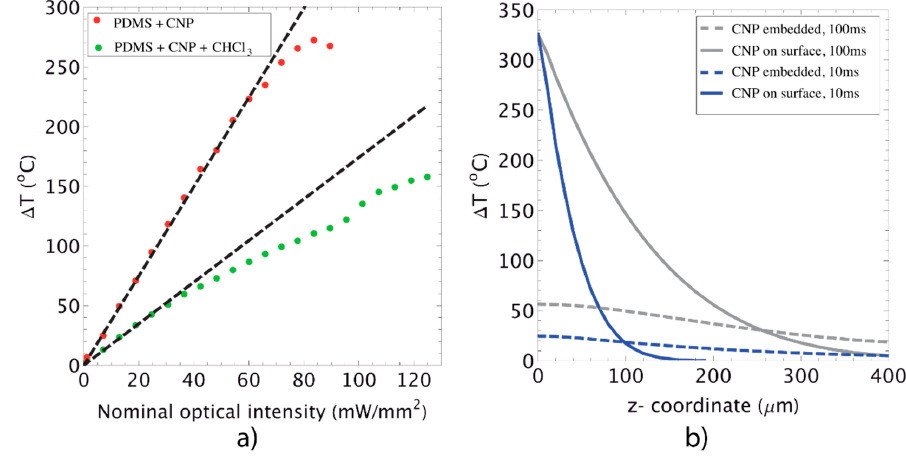
Figure 4. Heat generation and transfer in PDMS/CNP membranes: ( a ) comparison of the experimental ∆ T (dots) and theoretical (dashed lines) values using Equation (8) and the parameters given in Table 1. The parameter n in Equation (8) was set to 48 and t = 1 min, which was the experimental time to attain a steady value. The nominal optical intensities were calculated as I N “ P o { π w 2 o , where w o is the spot radius estimated by using the NA of the optical fiber and fiber tip-membrane separation (5.82 mm); ( b ) comparison of the theoretical ∆ T profiles along the membrane thickness using Equation (8) and (10) for the two CNP dispersion types: one where the CNP are dispersed in all the polymer matrix, and another where the CNP are deposited just on the irradiated surface.